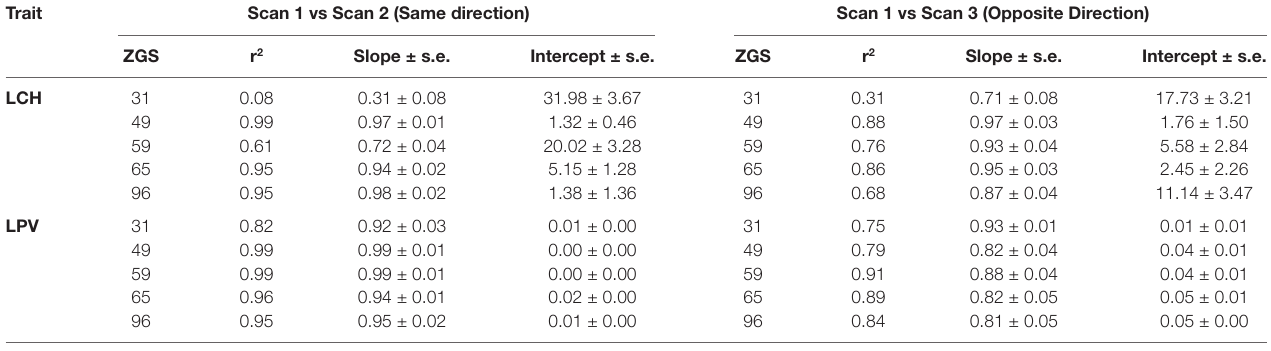
TABLE 3 | Coefficient of determination (r 2 ) and components (slope ± standard error, and intercept ± standard error) for linear regression models between repeated scans in the same and opposite directions, processed for the traits LiDAR Canopy Height (LCH) and LiDAR Projected Volume (LPV), at each sample time (ZGS) at Roseworthy.